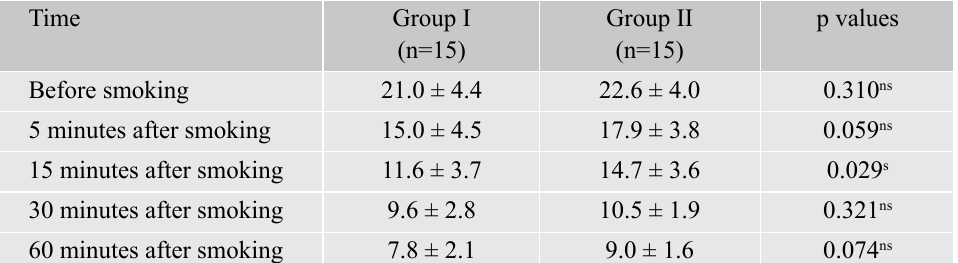
Table I: Mean comparison of effects of smoking on gallbladder volume (in cm 3 ) between two groups